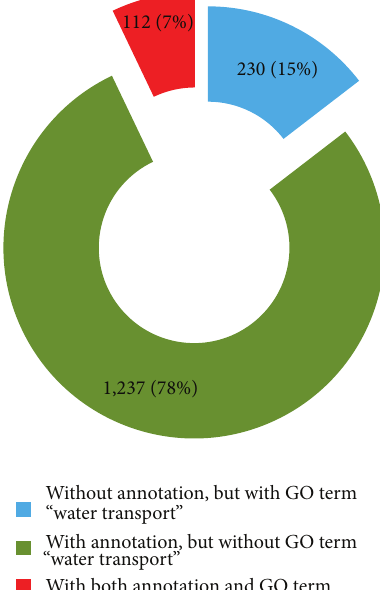
Figure 1: Percentage of HT-SuperSAGE unitags from sugarcane plants (24h of continuous dehydration or regular daily irrigation) identified as potential aquaporins after keyword searches in the EST annotation (“ aquaporin ,” “ tonoplast intrinsic protein ,” “PIP,” “TIP,” “NIP,”“SIP”)orintheGOterms(“ watertransport ”).Totalofunitags: